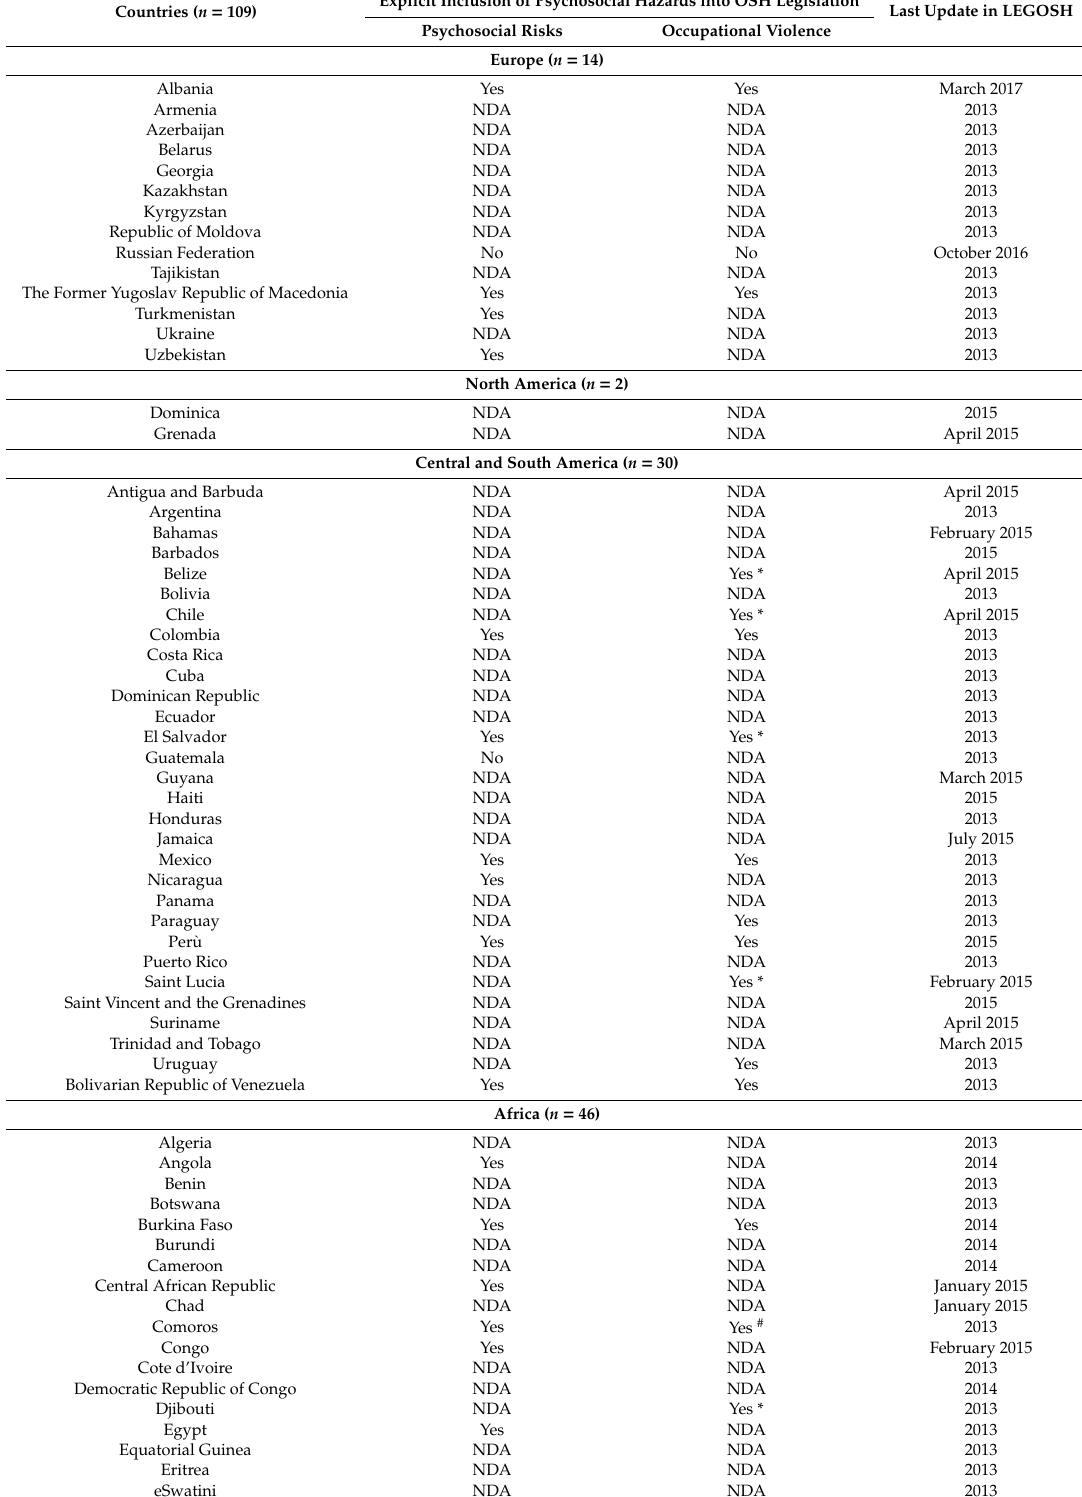
Table A2. Characteristics of OSH legislation concerning psychosocial hazards and workplace violence in developing